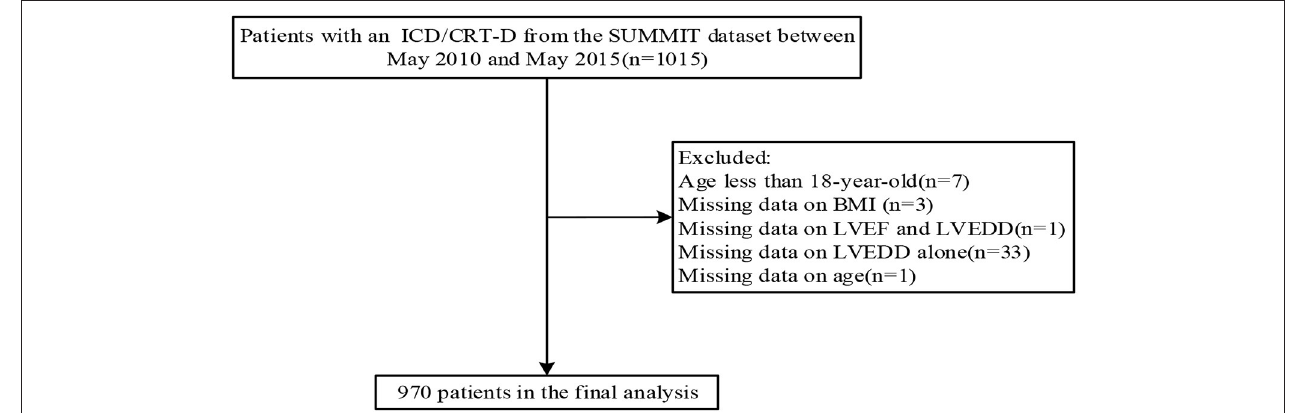
FIGURE 1 | Flowchart of the study population. Abbreviations are shown in Table 1 .